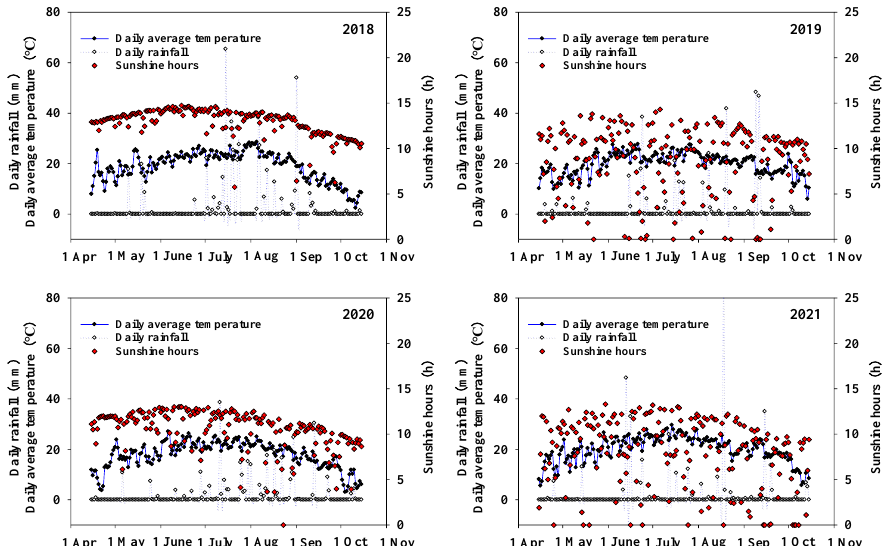
Figure 1. Daily values of main meteorological factors in the analyzed years during the growth period in the experimental area. Table 1. The main growth duration days of different periods of analyzed maize hybrids.